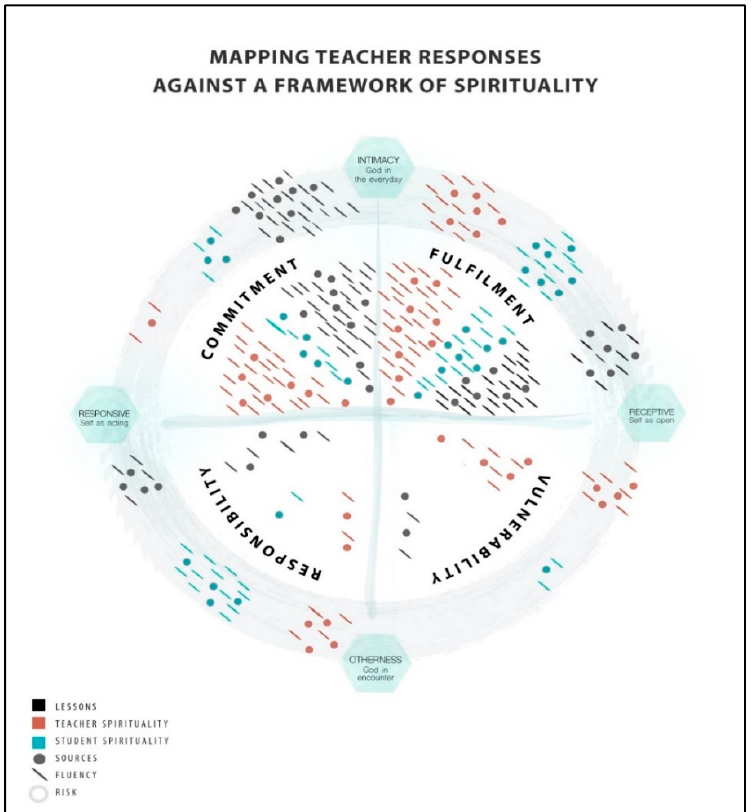
Figure 9. Dr. Madden’s spirituality framework.